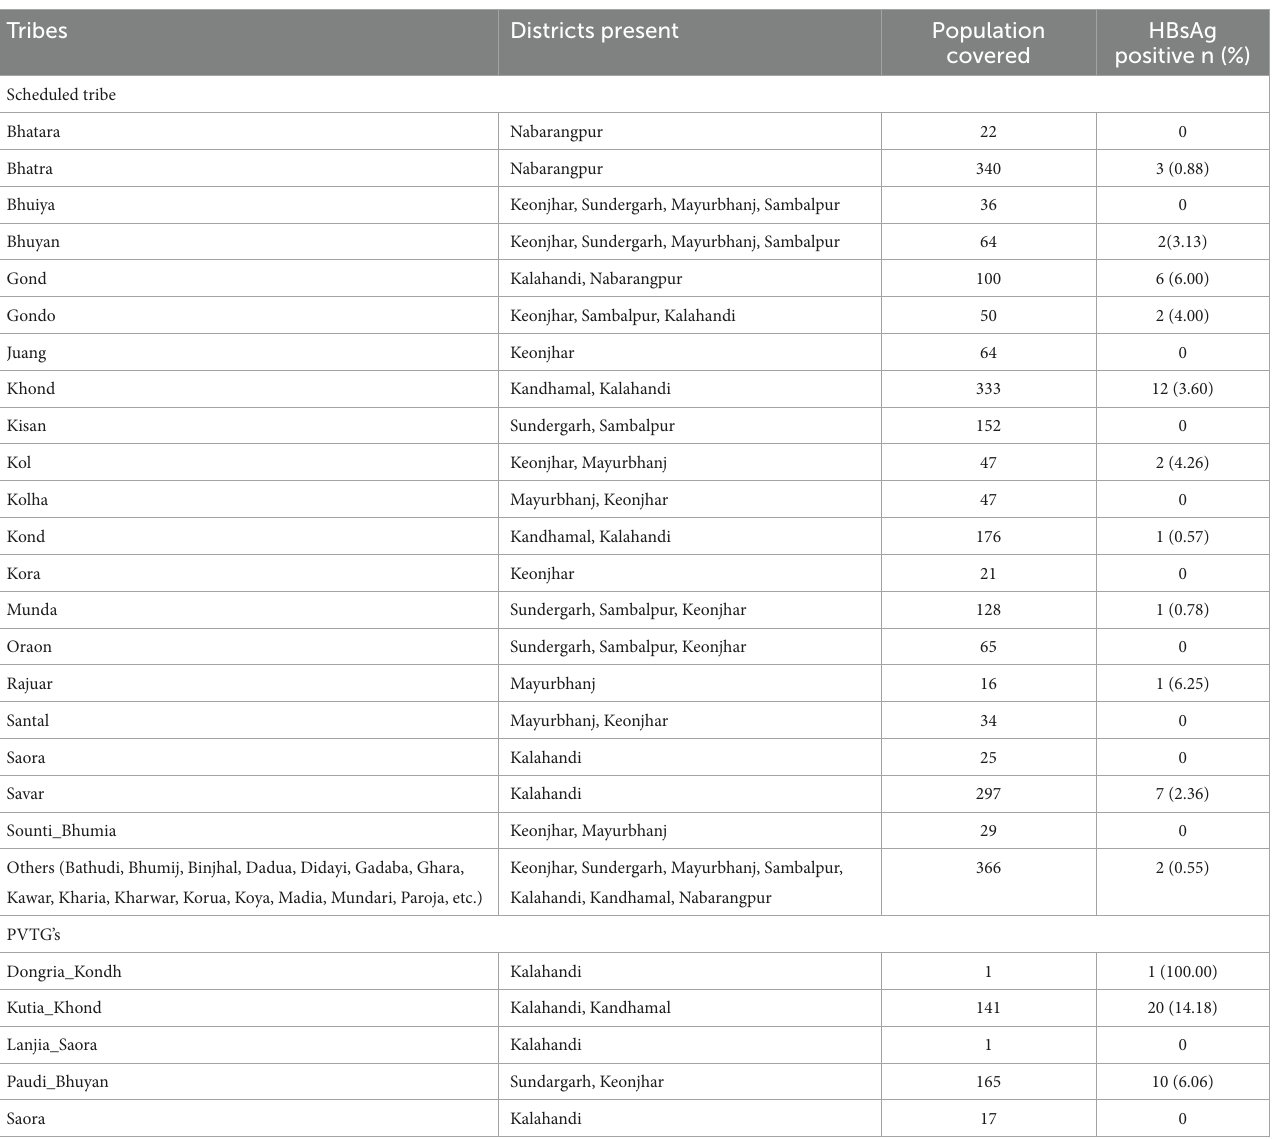
TABLE 2 The HBsAg positivity among various tribal community. Tribes Districts